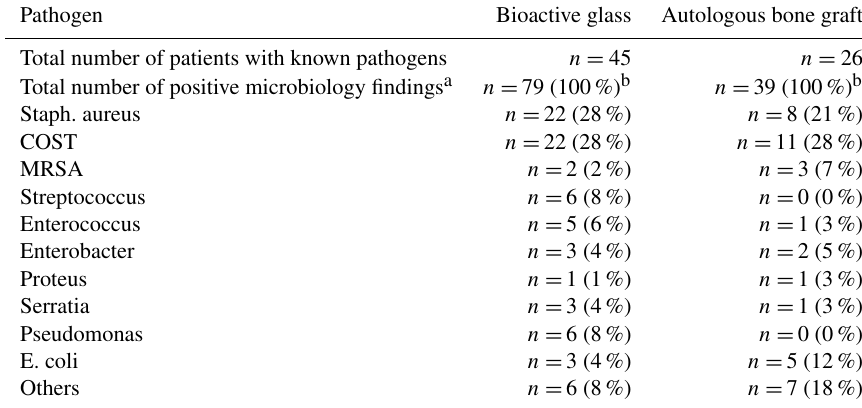
Table 2. Causative pathogens identified preoperatively and their proportions. Pathogen Bioactive glass Autologous bone graft Total number of patients with known pathogens